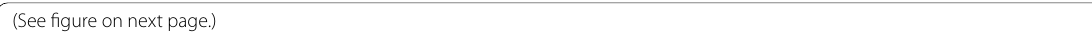
Fig. 2 Effect of ibandronate (IB) treatment on MCT induced rat PAH module. A RVSP and RV/(LV per group. B The probability of survival in the three groups. n thickness was calculated and showed in right. n independently replicated in triplicate. *P <